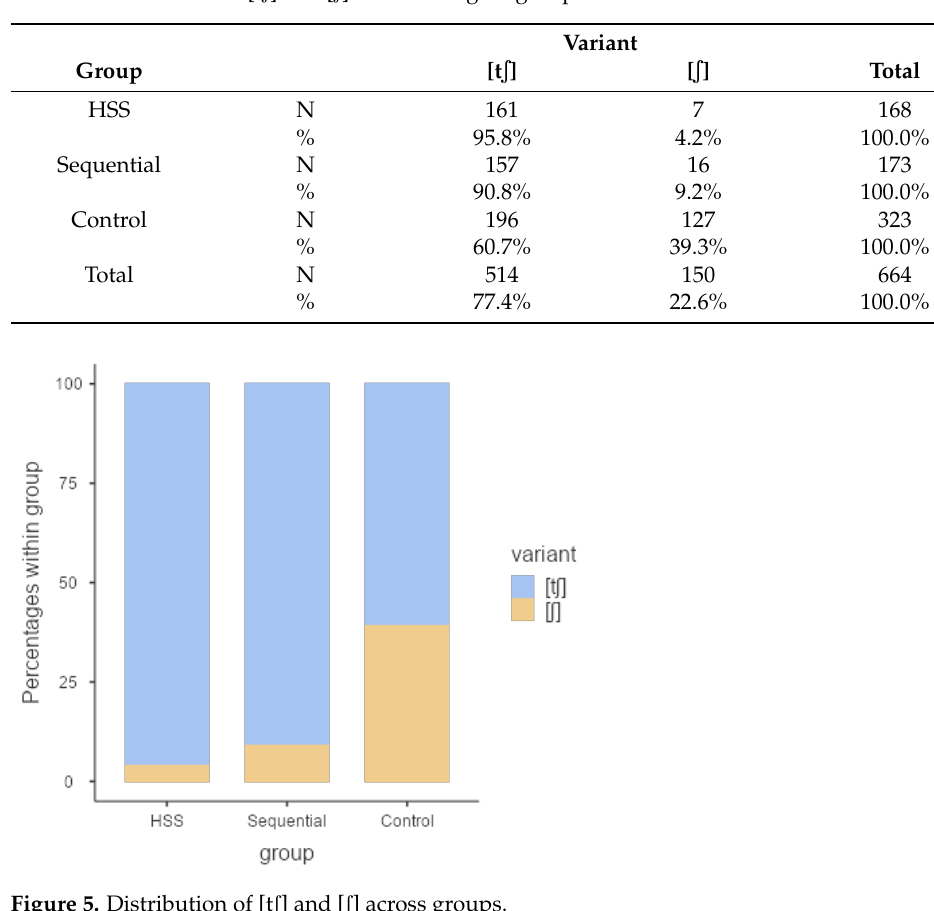
Table 2. Distribution of [t ʃ ] and [ ʃ ] across bilingual groups.